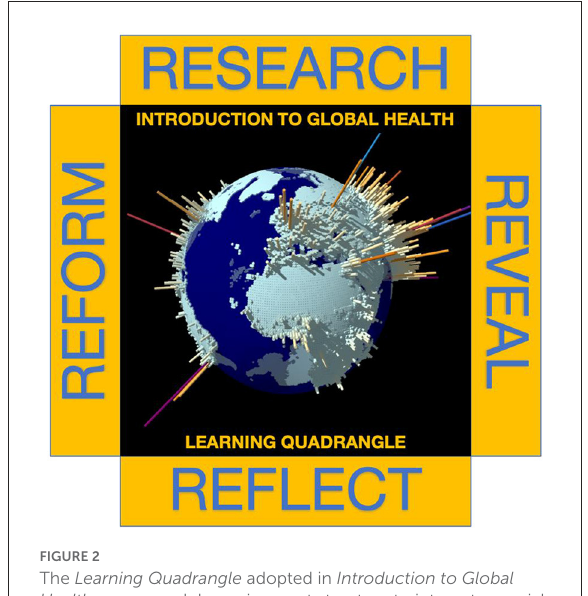
FIGURE2 The Learning Quadrangle adopted in Introduction to Global Health uses a modular assignment structure to integrate special topics into the curriculum. Diagram of Earth with population density spikes by Anders Sandberg - https://www.flickr.com/